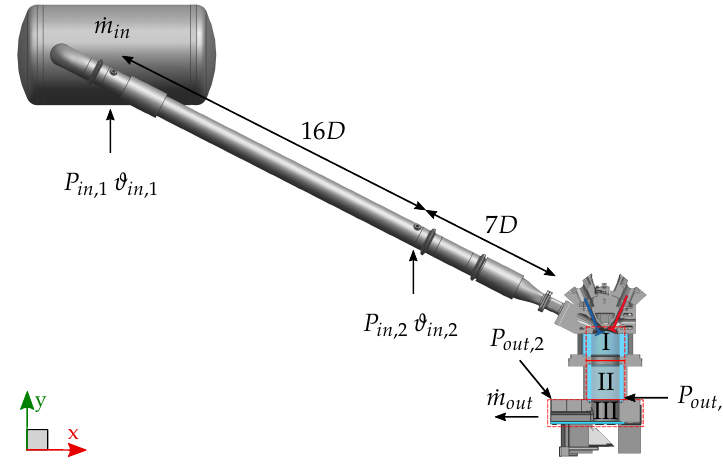
Figure 2. Flow bench and intake system overview. The inner diameter of the intake pipes D is 56.3 mm. Experimental sections include the standard engine- (I), the Flow bench- (II) and the Outlet duct optical access